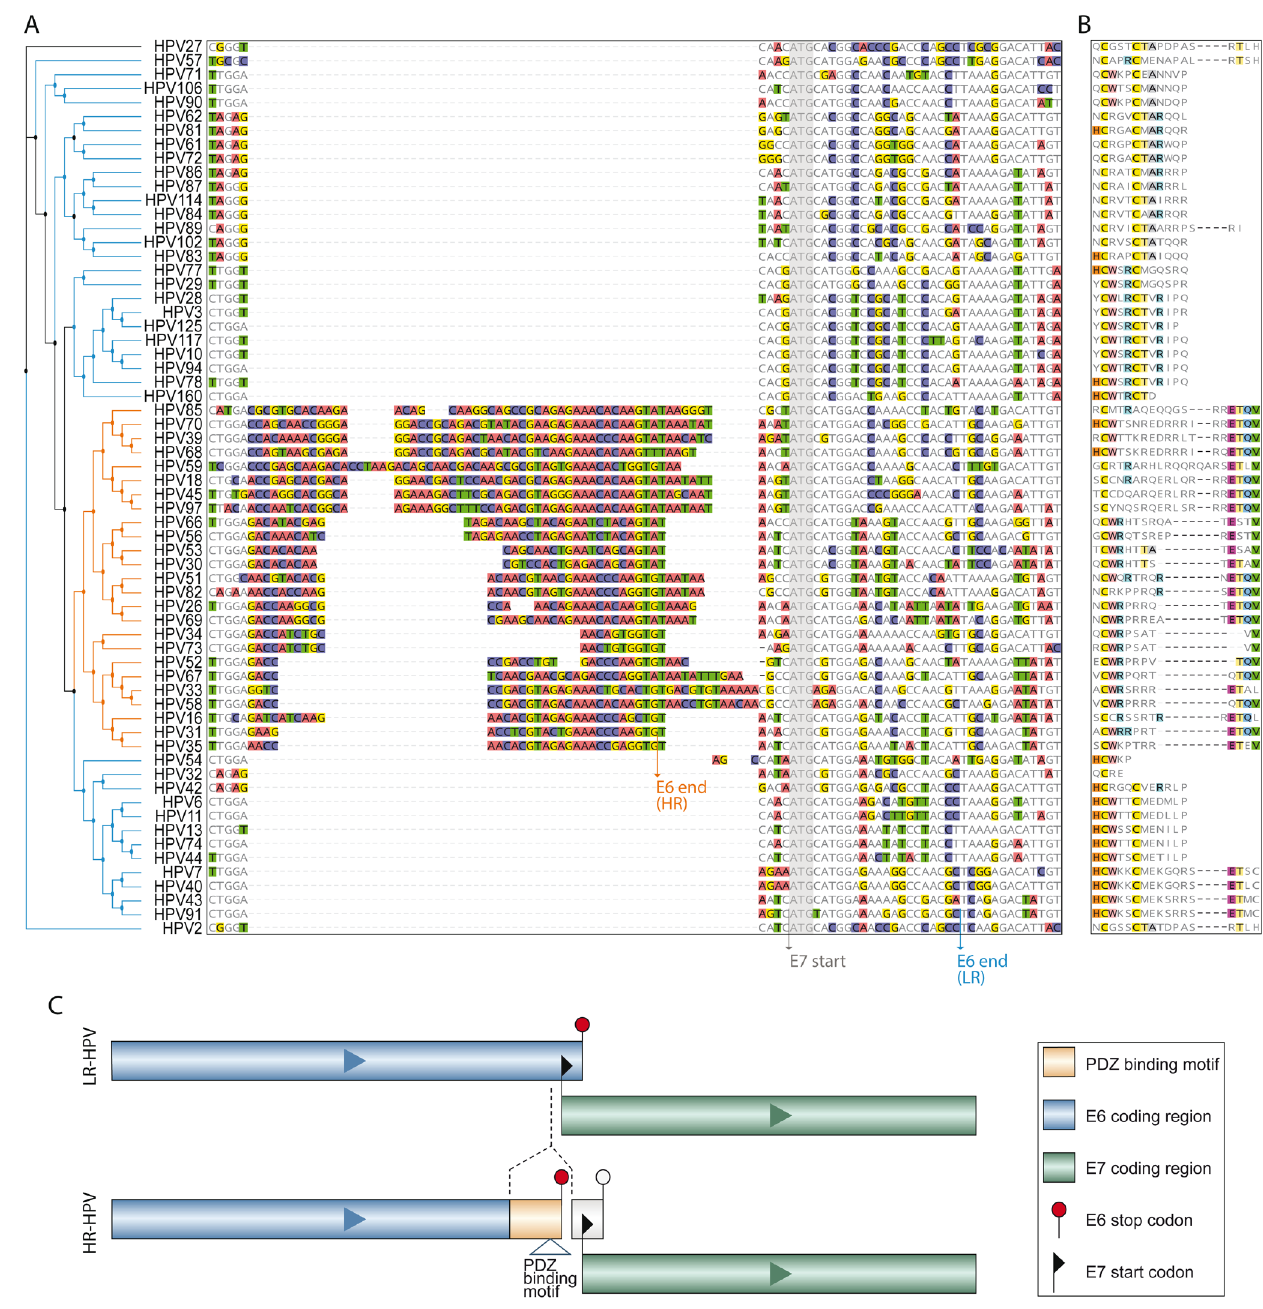
Figure 2. HR-HPV-specific sequence insert. ( A ) Nucleotide sequence alignment of alpha-HPVs (blue, LR-HPV; orange, HR-HPV sequences). Arrows: Grey, E7 start codon for most HPV types; Blue and Orange, E6 stop codons that are distinct between LR-HPV and HR-HPV. ( B ) Alignment of the C-terminal amino acid sequences of E6 proteins of alpha-HPVs. ( C ) Schematic representation of the E6/E7 separation caused by the insertion in the 3’-terminal region of E6 and the proximity of E6 stop and E7 starts in HR-HPV.